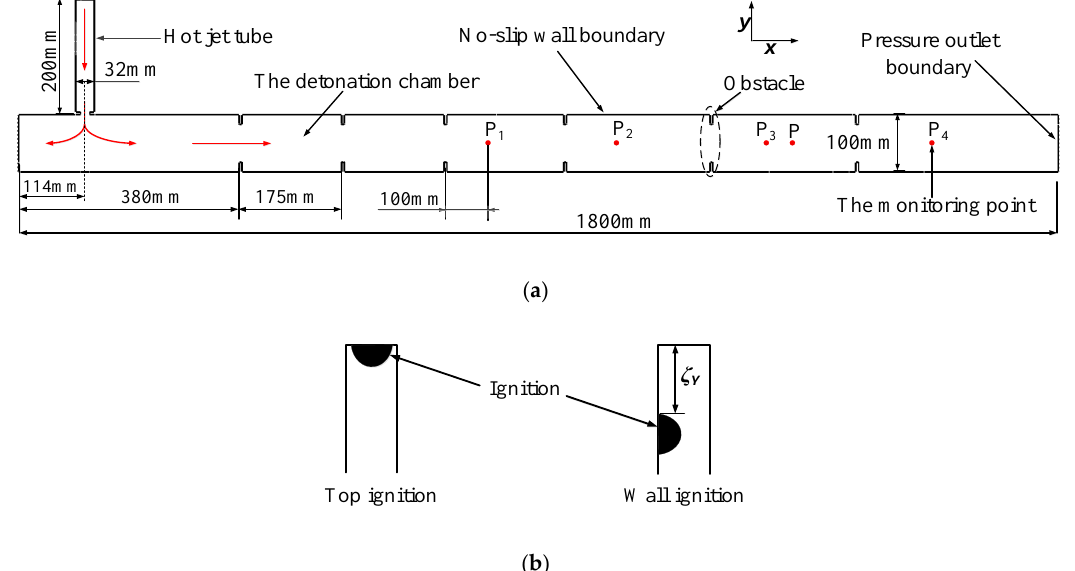
Figure 1. Schematic of geometry, ( a ) computational domain and ( b ) ignition position.